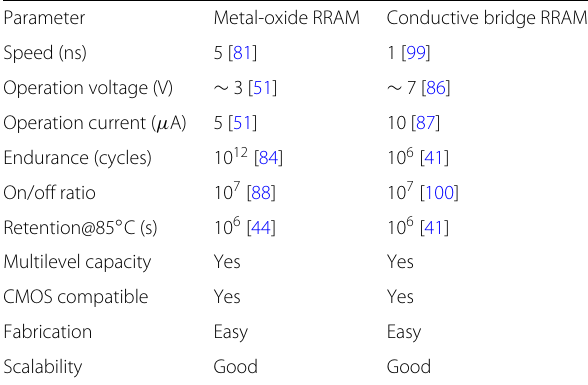
Table 3 Comparison between metal-oxide RRAM